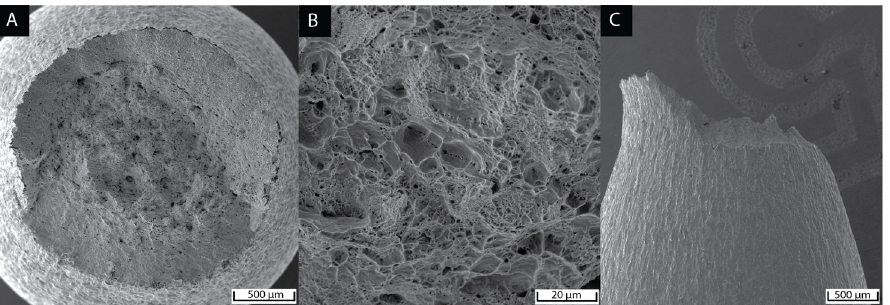
Figure 9. Top view of 0-wt% Ni fractured sample with 40.7% martensite content ( A , B ). Side view of the same sample ( C ).